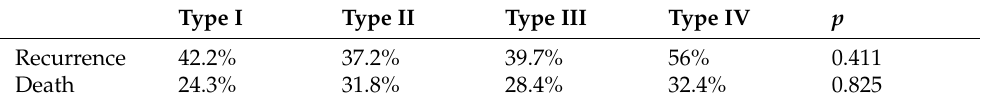
Table 5. Univariate analysis. Relationship between Borrmann types, tumor recurrence and death.